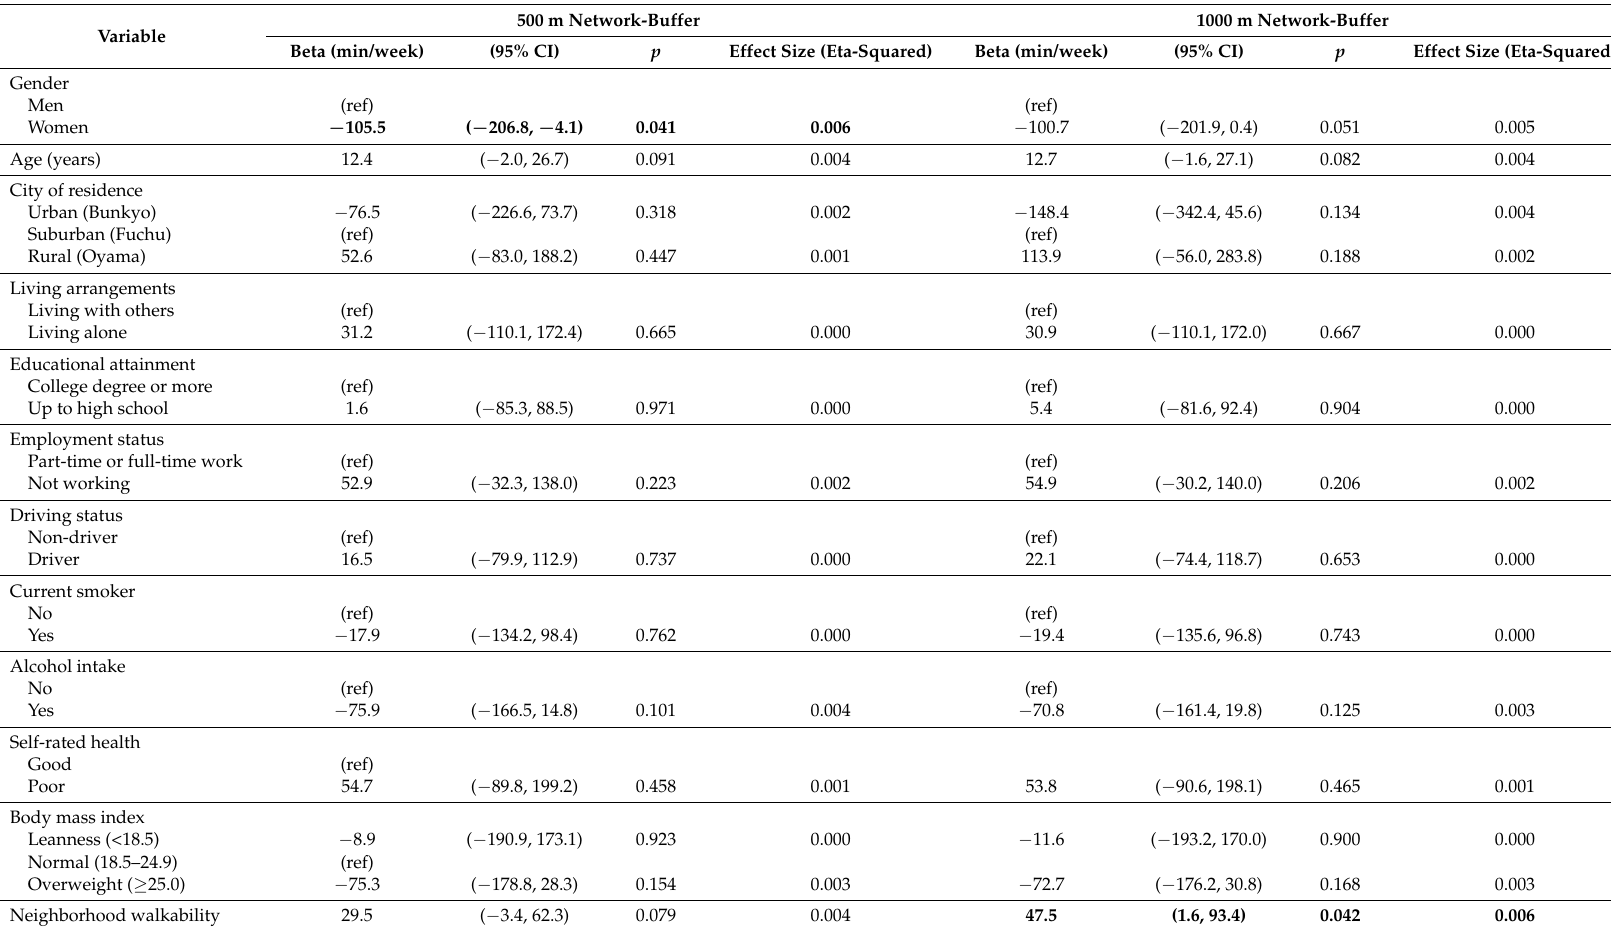
Table 3. Association between change of walking in the 5-year period and neighborhood walkability/socio-economic status: Multivariate regression analyses.